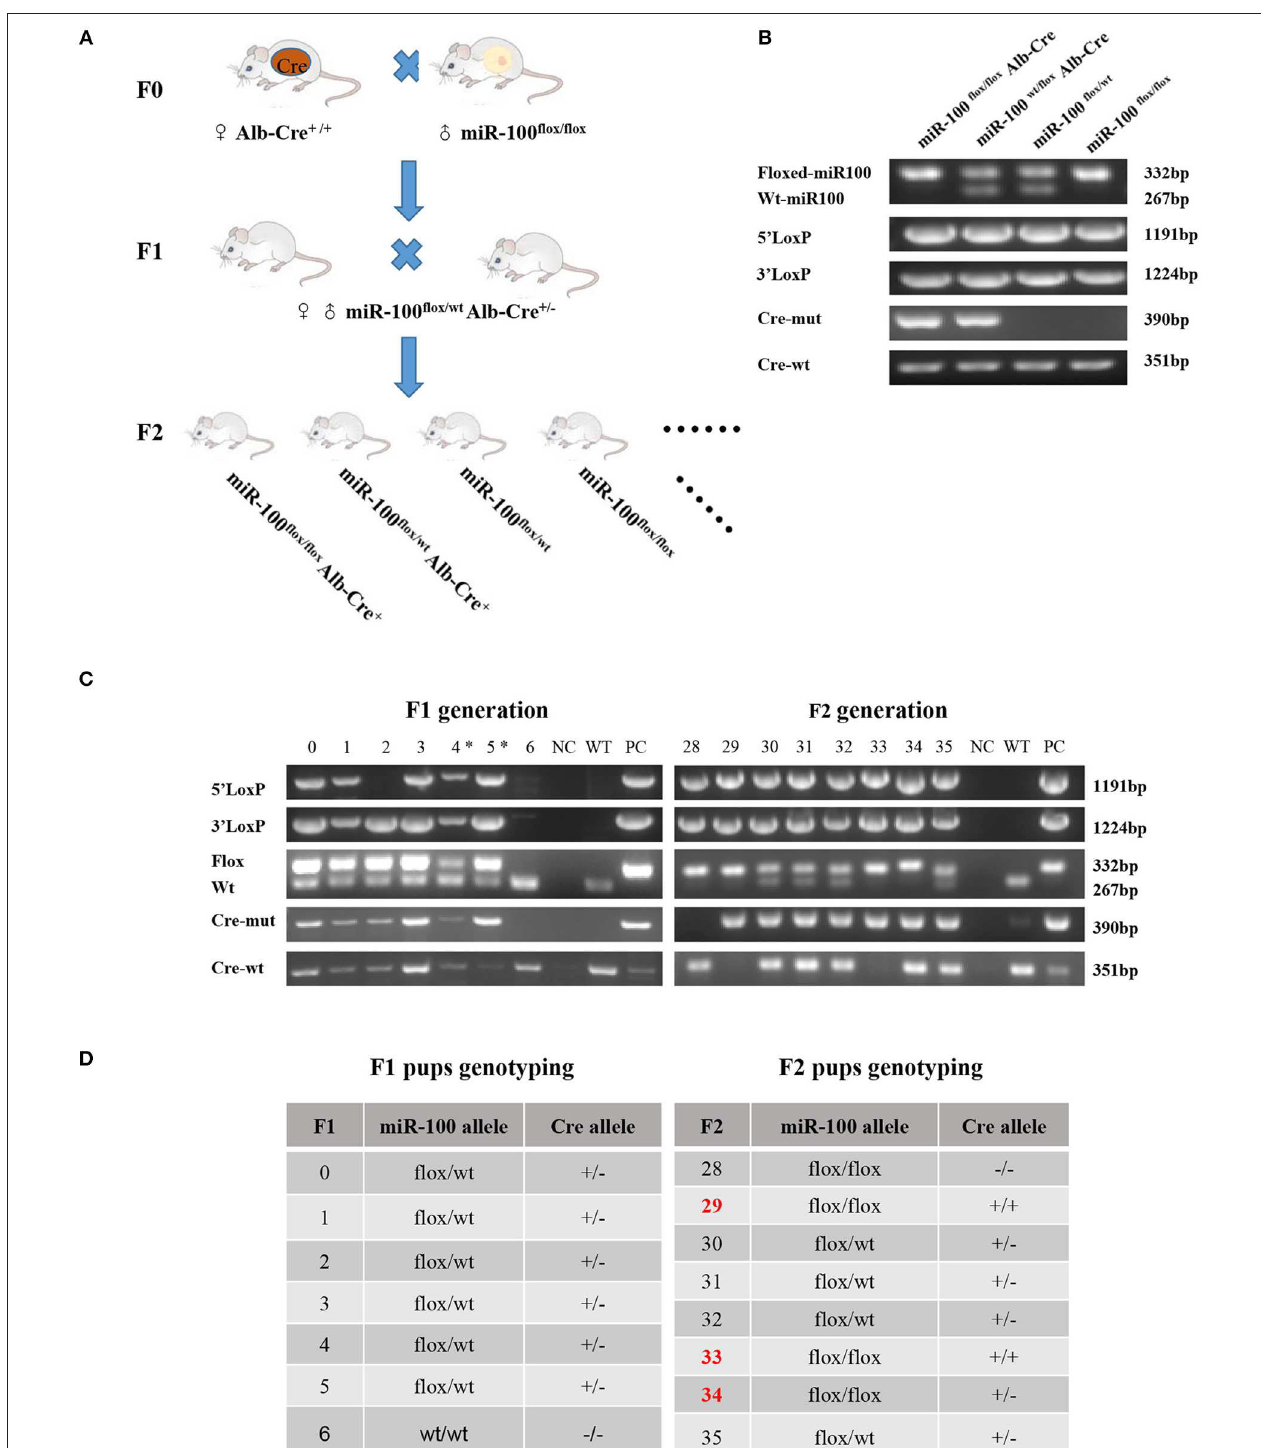
FIGURE 2 | Generation of mice with Alb-Cre mediated miR-100 deletion. (A) Strategy for mice mating to generate mice bearing homozygous floxed miR-100 and cre-mut simultaneously. (B) PCR-based genotyping showing DNA products having sizes specific for the floxed allele, Cre allele as well as 5 ′ and 3 ′ homology arms in tail DNA. (C) Representative genotyping of F1 (left) and F2 (right) generation. (D) The corresponding genotypes of F1 and F2 mice are shown, miR-100 flox / flox Alb-Cre + mice were selected as miR-100 knockout mice. F2 mice resulted from breeding pair of #4 F1 female and #5 male, designated with (*).